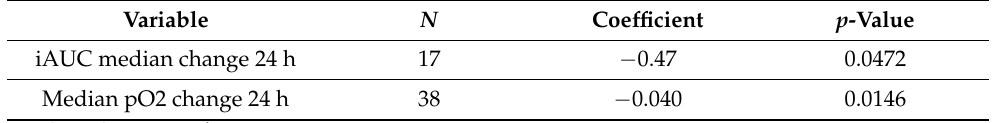
Table 3. Physiological Predictors of Tumor Volume Change: Thermal Dose Fractionation Trial. Variable N Coefficient p -Value iAUC median change 24 h 17 −